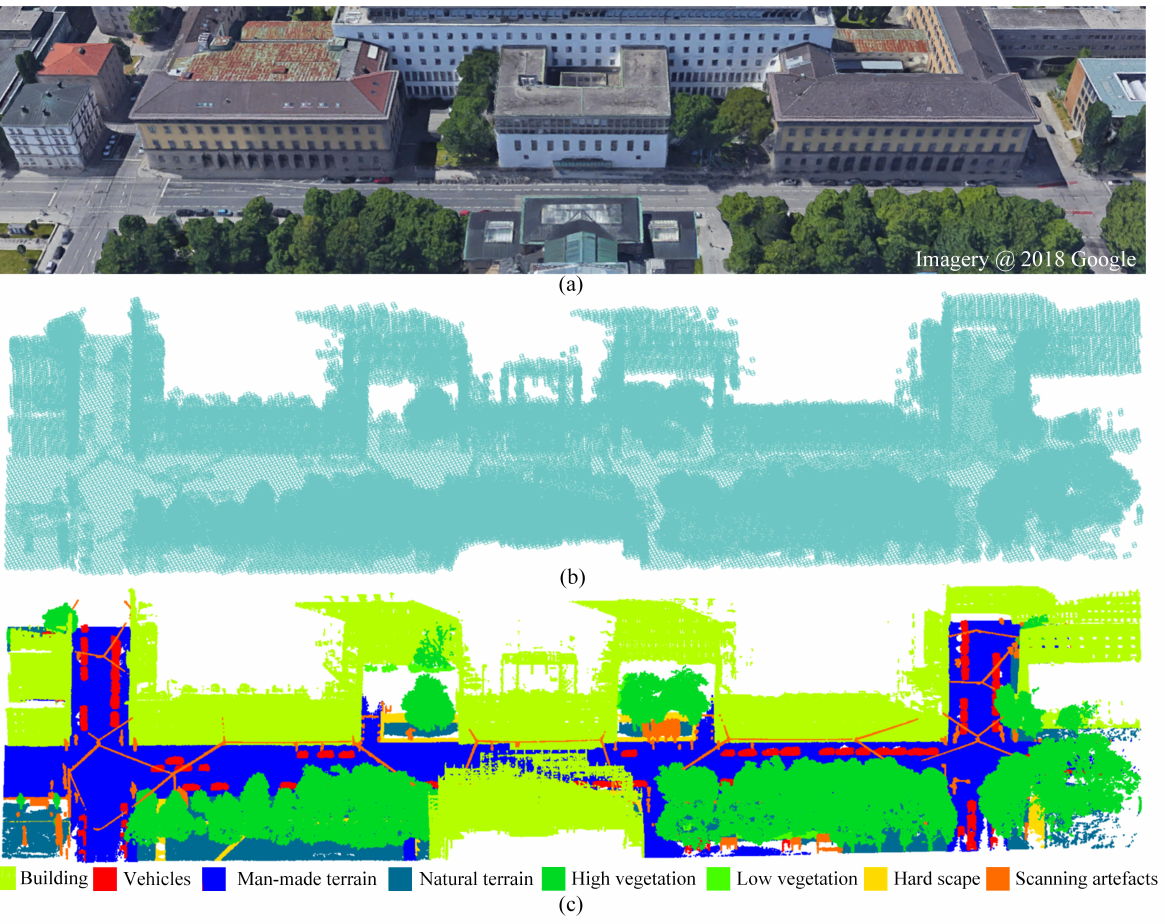
Figure 1. (a) Real scene of the TUM main entrance from Google Maps, 2018. (b) Voxelized 3D space. (c) Labeled reference MLS point